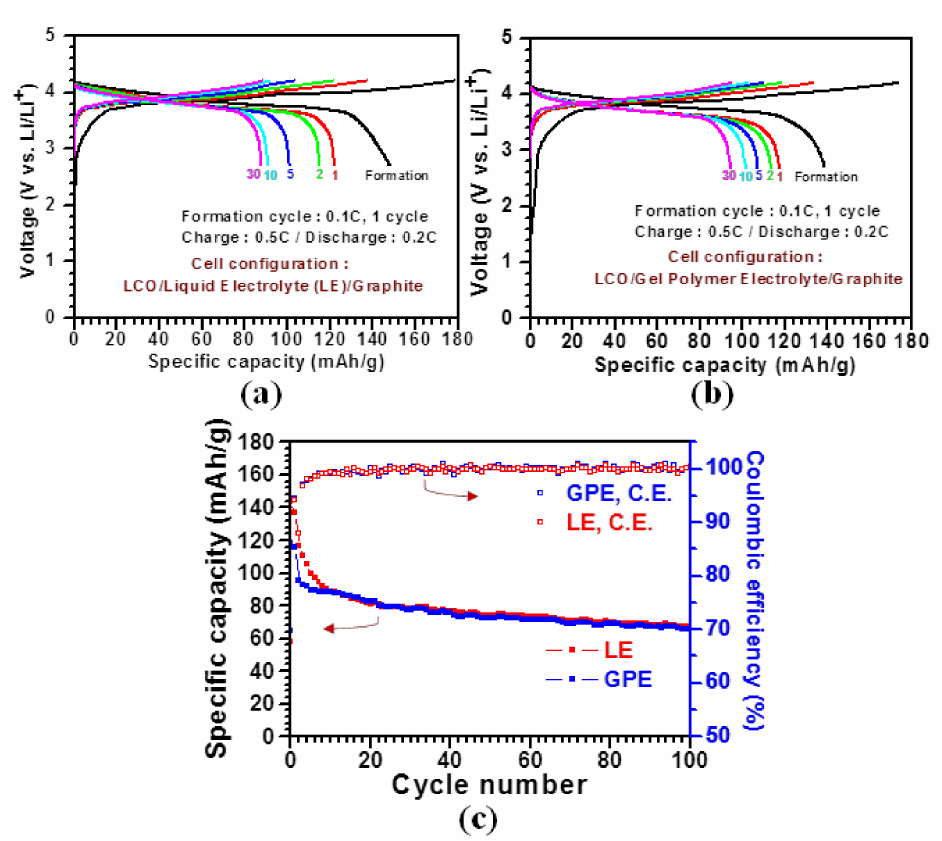
Figure 4. A comparative study of the performance of LIB cells incorporated with the commercialized PP and the PVDF- co -HFP separators. ( a , b ) Galvanostatic charge and discharge profiles of the LIB full-cells with the two different separators at 0.5 C for 30 cycles, and ( c ) cycling performance of the LIB half-cells with the two different separators at 0.5 C for 100 cycles and their corresponding coulombic